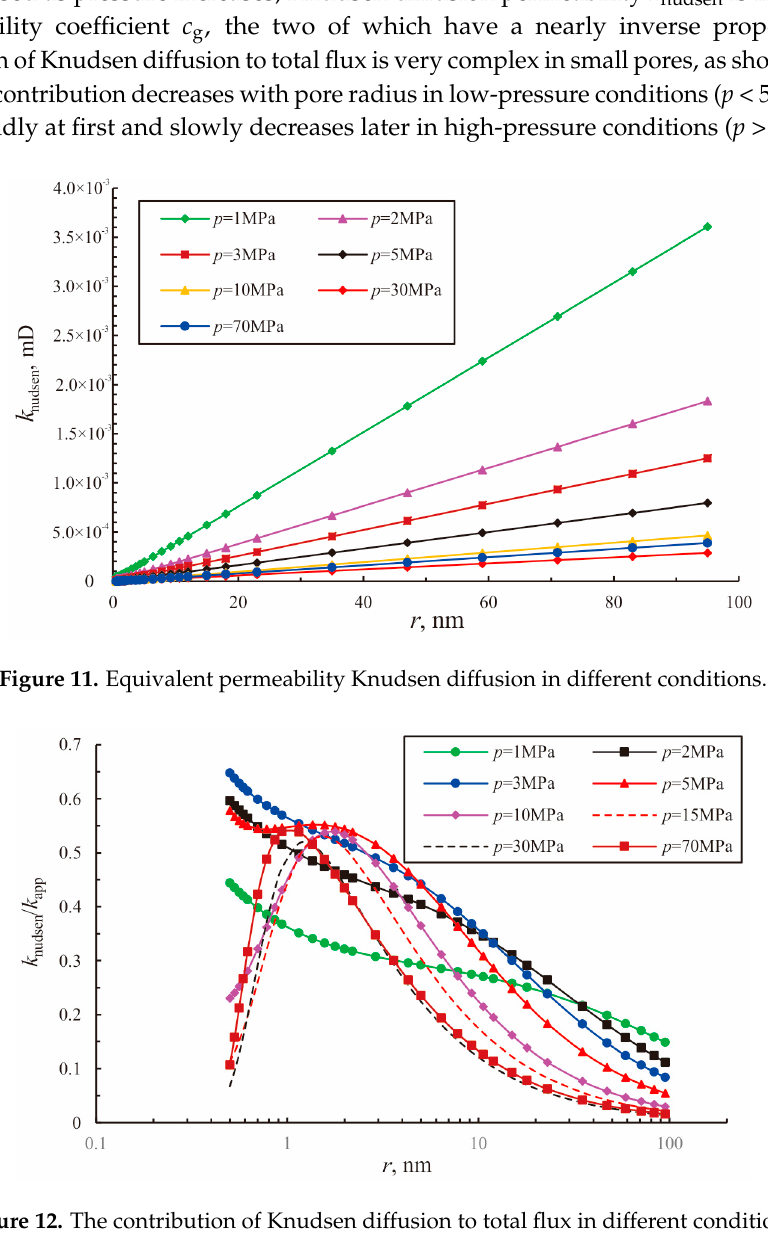
Figure 12. The contribution of Knudsen diffusion to total flux in different conditions.